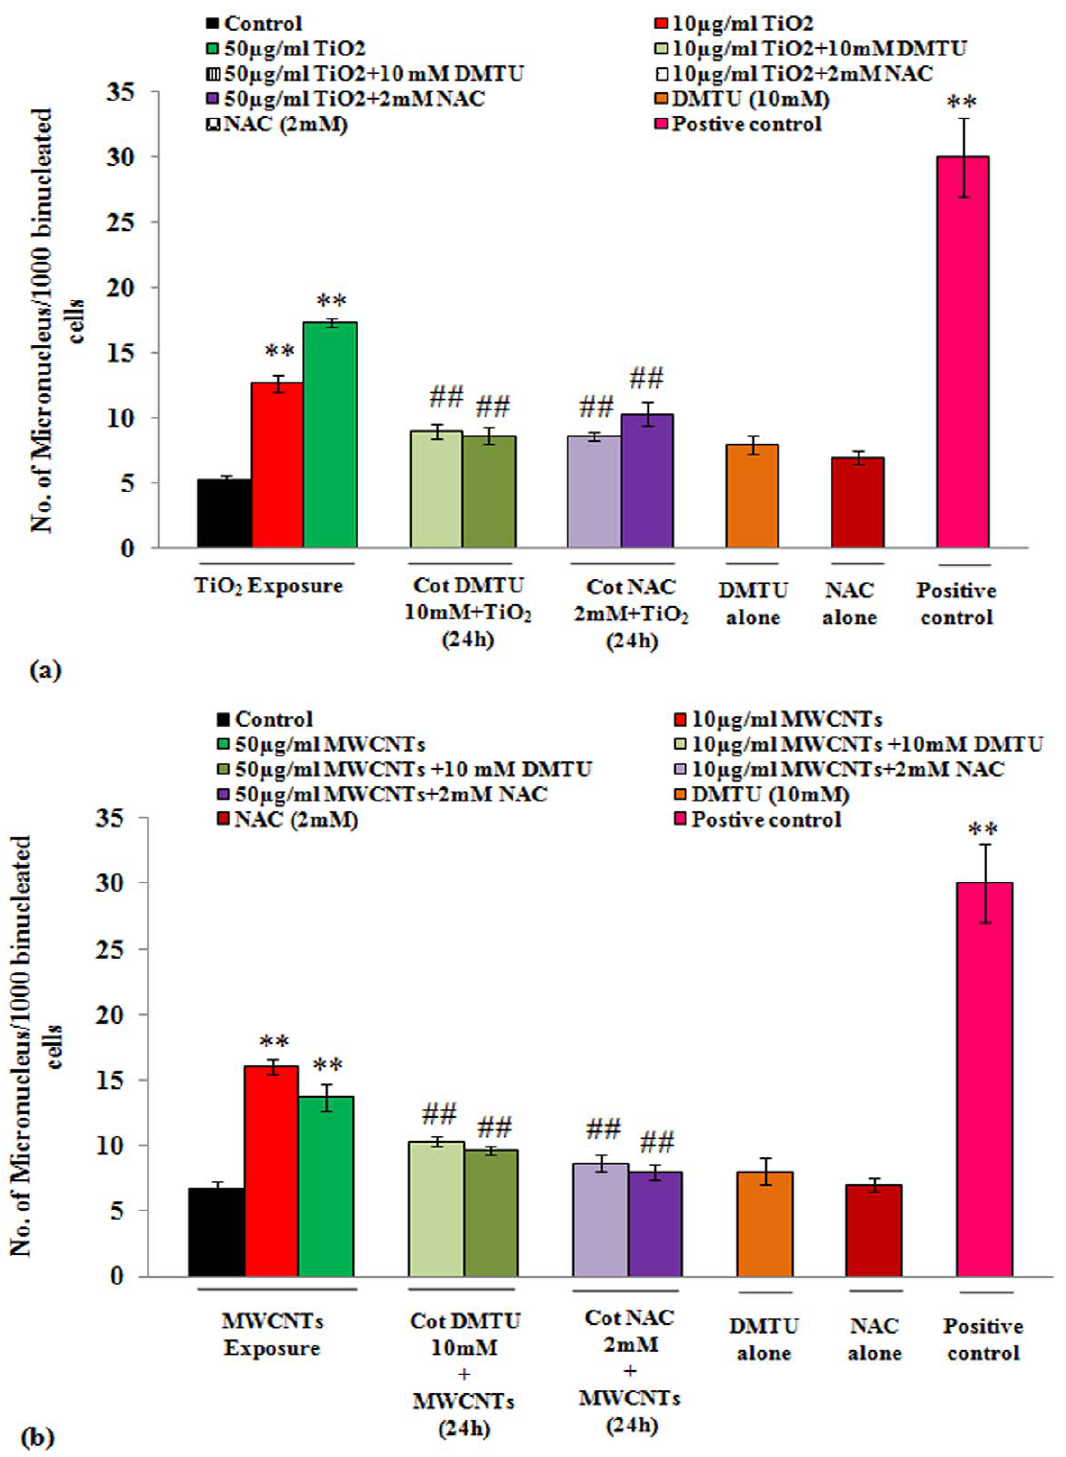
Figure 5. Effect of DMTU/NAC on the reduction of micronuclei formation in A549 cells exposed to TiO 2 -NPs/ MWCNTs. ( a ) The cells were exposed to TiO 2 -NPs (10 & 50 m g/ml) with or without DMTU (10 mM) and NAC (2 mM) for 24 h. Ethyl methanesulfonate (6mM) was used as a positive control. Each data point represents the mean of three slides. A total 1000 bi-nucleated (BN) cells with well-defined cytoplasm were scored. Parallel sets were also run under identical conditions by exposing the cells only with either of DMTU or NAC. This group was used to compare the data between scavenger treated Vs non-scavenger treated cells. All values are mean 6 S.E. of 3 experiments. ** P , 0.01 (unexposed control Vs TiO 2 -NPs exposure). ## P , 0.01 (TiO 2 -NPs exposure Vs DMTU/NAC treatment). ( b ) The cells were exposed to MWCNTs (10 & 50 m g/ml) with or without DMTU (10 mM) and NAC (2 mM) for 24 h. Ethyl methanesulfonate (6mM) was used as a positive control. Each data point represents the mean of three slides. A total 1000 bi-nucleated (BN) cells with well-defined cytoplasm were scored. Parallel sets were also run under identical conditions by exposing the cells only with either of DMTU or NAC. This group was used to compare the data between scavenger treated Vs non-scavenger treated cells. All values are mean 6 S.E. of 3 experiments. ** P , 0.01 (unexposed control Vs MWCNTs exposure). ## P , 0.01 (MWCNTs exposure Vs DMTU/NAC treatment). doi:10.1371/journal.pone.0025767.g005 PLoS ONE |